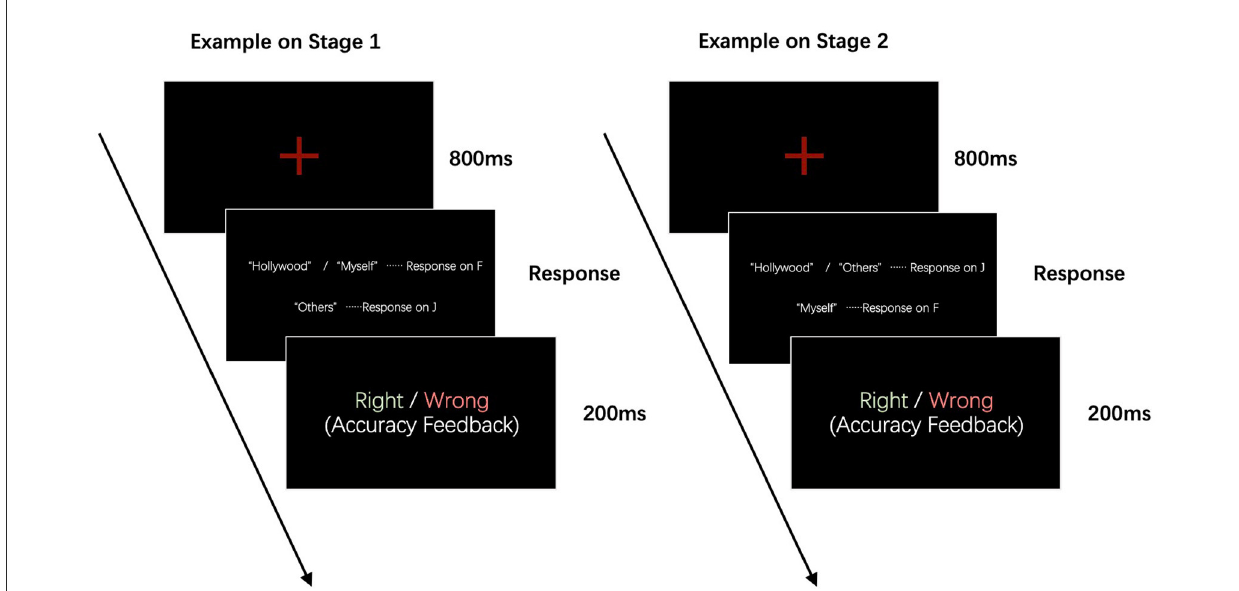
FIGURE2 Examples of the procedure of SC-IAT. In stage 1, words describing “Western culture” and “self” were categorized on the “F” key, and words describing “others” were categorized on the “J” key; in stage 2, words describing “Western culture” and “others” were categorized on the J key, and words describing “self” were categorized on the F